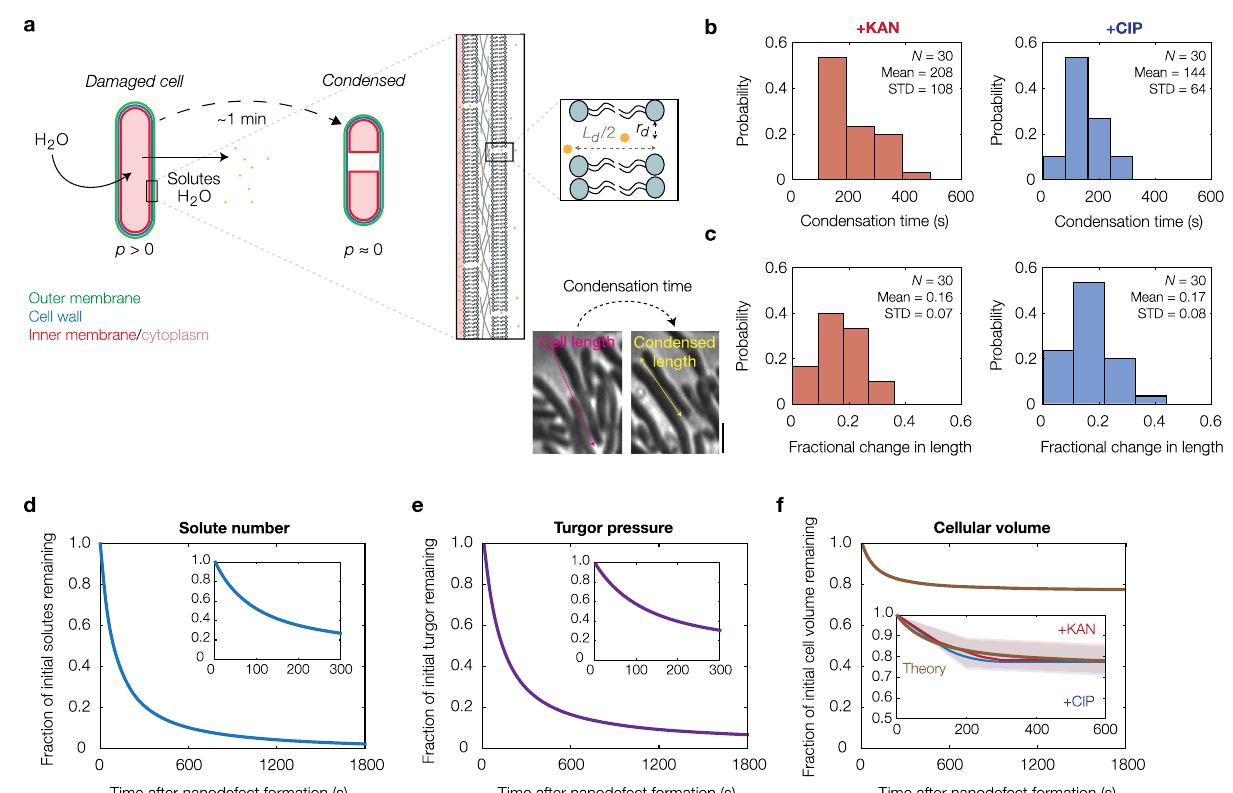
Fig. 2 Cytoplasmic condensation emerges from subtle, nanometer-scale membrane defects. a Model of condensation due to membrane nano-defect formation and subsequent solute leakage. Membrane nano-defects are modeled as circular channels that extrude through both the inner and outer membranes, with a typical radius of r d and a typical length of L d . Cytoplasmic condensation occurs as the cellular turgor ( p ) decreases. For details of the model, see Supplementary Note 1. b Empirically observed distributions of condensation times in kanamycin-treated and cipro fl oxacin-treated cells at 10× MIC. The cell numbers ( N ), population means, and standard deviations (STD) are indicated. c Same as panel ( b ) but for distributions of cell length changes, as illustrated in phase contrast for a typical cipro fl oxacin-treated cell (10× MIC) in the inset (left; scale bar, 3 μ m). d – f Model predictions for solute number ( d ), turgor pressure ( e ), and cell volume ( f ) against time after membrane nano-defect formation, for the characteristic parameter values summarized in Supplementary Table 2. (Insets) Plots for short times. The empirically observed decreases in cellular volume as functions of time for the kanamycin-treated and cipro fl oxacin-treated (10× MIC) cells, represented in part by panels ( b ) and ( c ), are indicated by red and blue curves, respectively. Shaded regions indicate one standard